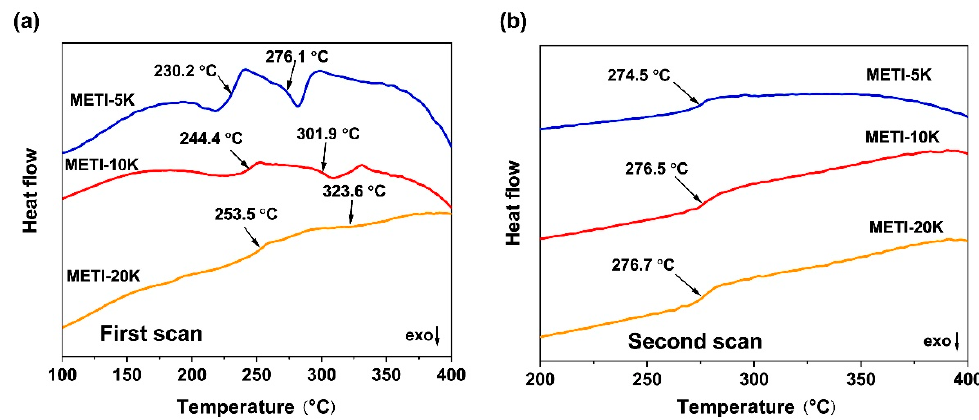
Figure 7. DSC diagrams of METI NFMs in nitrogen atmosphere. ( a ) first DSC scan; ( b ) second DSC scan. Table 3. Thermal properties of METI NFMs.